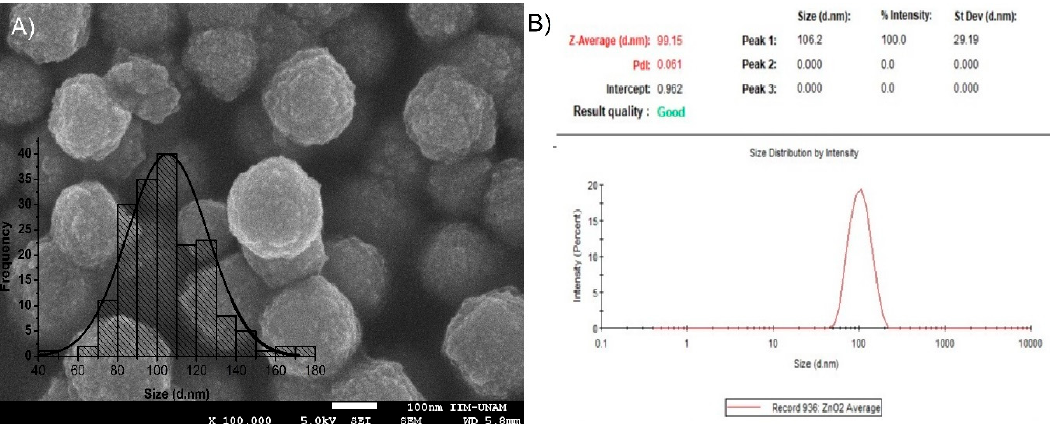
Figure 4. ( A ) SEM image with a gold coating and ( B ) hydrodynamic diameter (Dh) distribution by dynamic light scattering (DLS) analysis for ZnO 2 nanoparticles. The insert in the SEM image corresponds to a size distribution histogram of the ~100 nm in diameter particles.